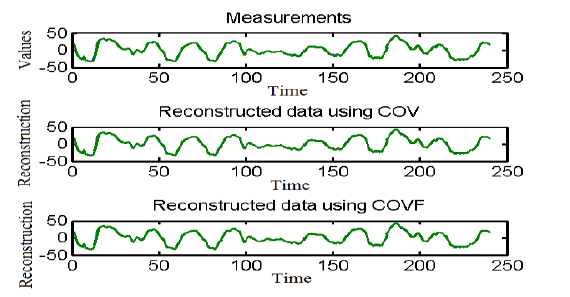
Figure 3: Reconstructed values and original measurements: AQI